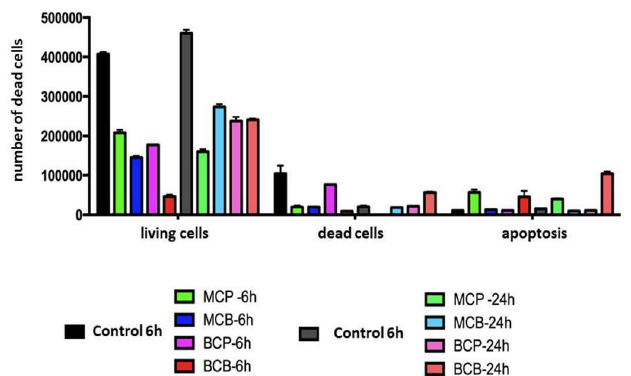
FIGURE 4 – Results obtained with image cytometer at 6 and 24 h of exposure.